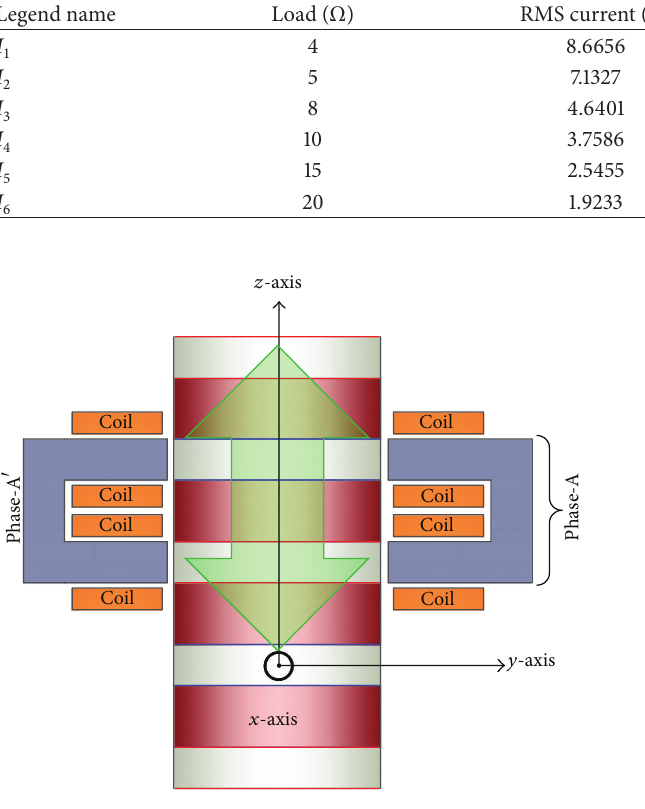
Figure 10: Direction of different forces.